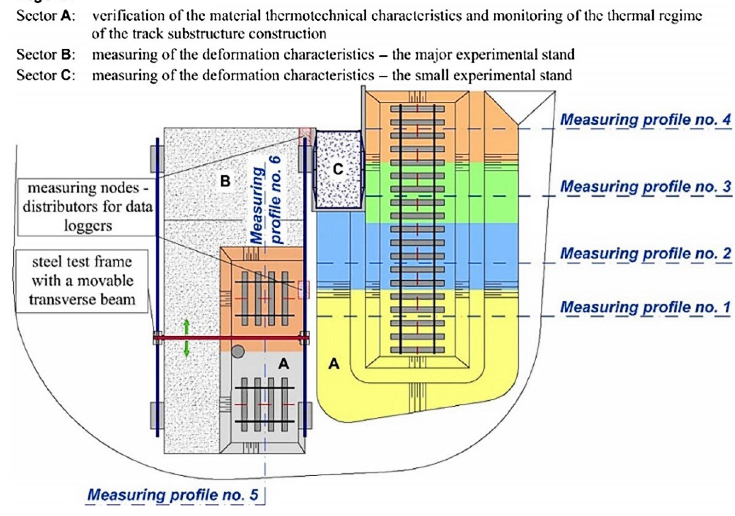
Figure 1. Experimental stand DRETM– ground plan (Pieš & Môcová, 2019)